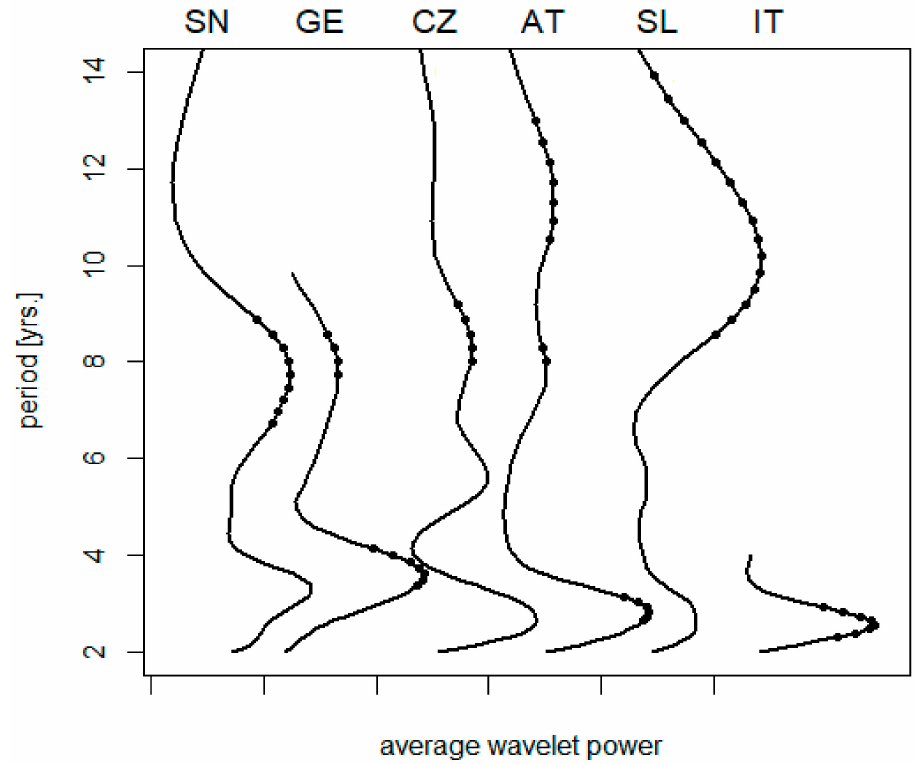
Figure 1. A collation of average wavelet power spectra of TBE fluctuations: (SN) Sweden, (GE) E. Germany, (CZ) the Czech Rep., (AT) Austria, (SL) Slovenia, and (IT) NE Italy; dots indicate where the signal exceeds random noise with 95% probability (truncated spectra are due to data